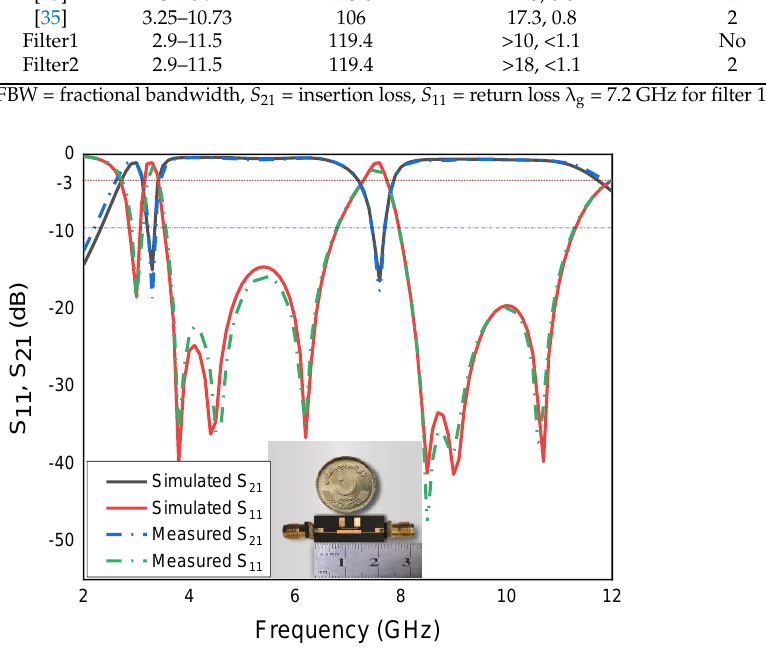
Figure 21. EM-simulated and measured frequency plots responses of the proposed dual-notched